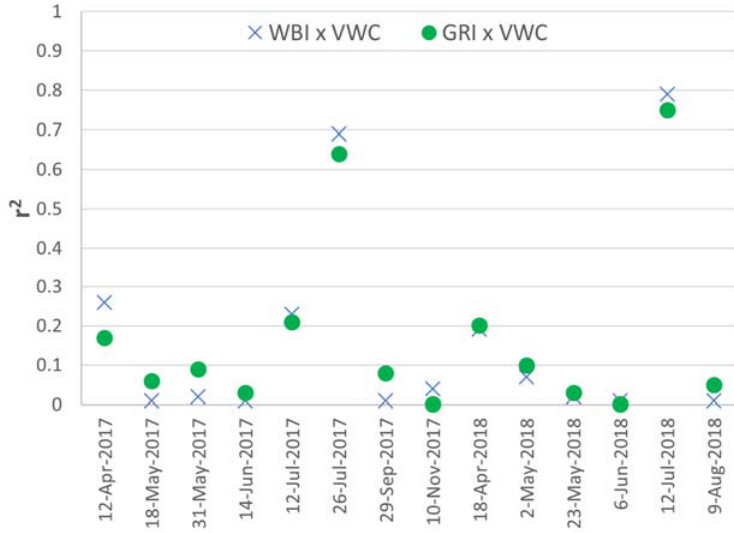
Figure 3. Nonlinear four parameter logistic regression between soil volumetric water content (VWC) and the narrowband water band index (WBI) and the green-to-red ratio index (GRI) by date.